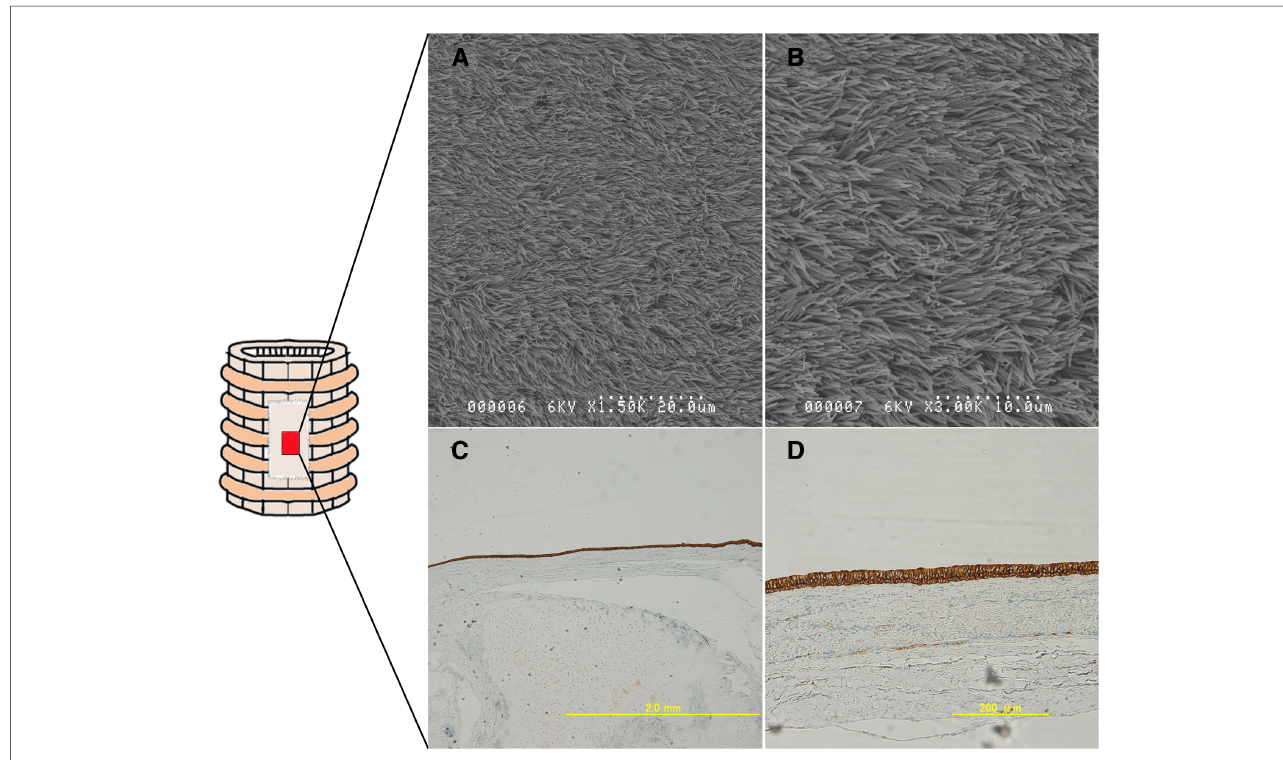
FIGURE 8 Epithelialization on the implanted ECM was assessed (within the red area). Group B : Cytokeratin AE1/AE3-stained samples(( A ); 4×, ( B ); 20×). The staining pattern was consistent with the presence of healthy epithelium. ( C,D ) Scanning electron microscopy images showing the regenerated pseudostrati fi ed, densely populated ciliated epithelium. The epithelium is indeed regenerated on the